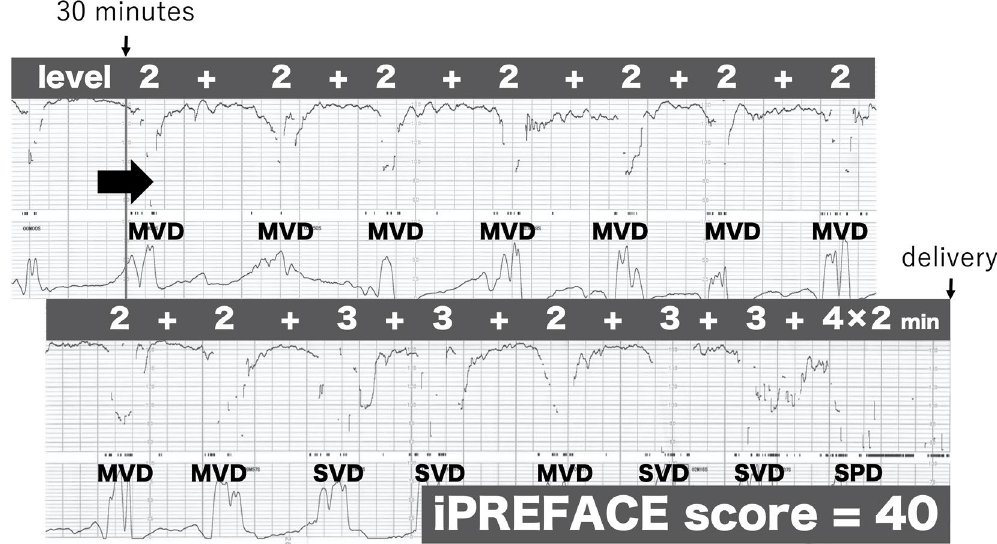
Figure 1. An example of the iPREFACE score determination. MVD, mild variable deceleration; SPD, severe prolonged deceleration; SVD, severe variable